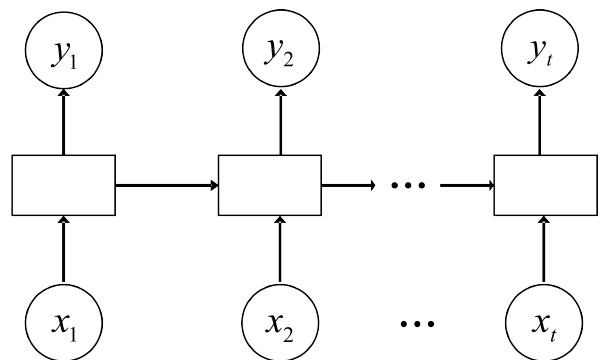
Figure 1. Conventional recurrent neural network (RNN) model architecture. The input is a time series, x t represents the input information at time t . The middle box represents the hidden state. y t represents the output at time t